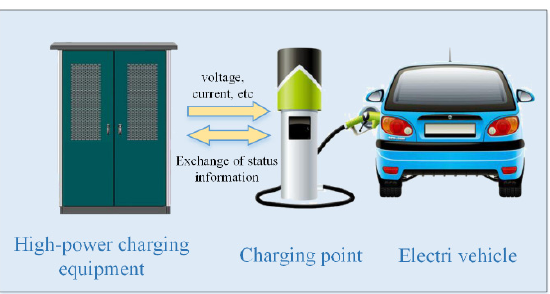
Figure 3. The relationship between high-power charging equipment, DC charging points, and EVs.